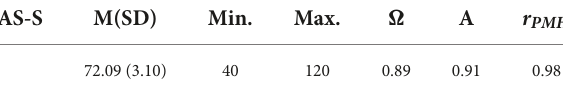
TABLE 5 Descriptive statistics, reliability, and convergent validity.